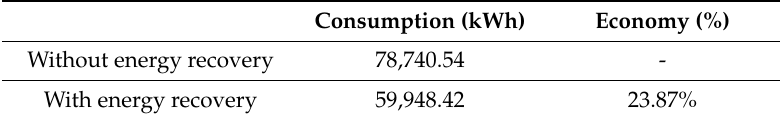
Table 4. Recoverable potential without limiting the storage capacity.